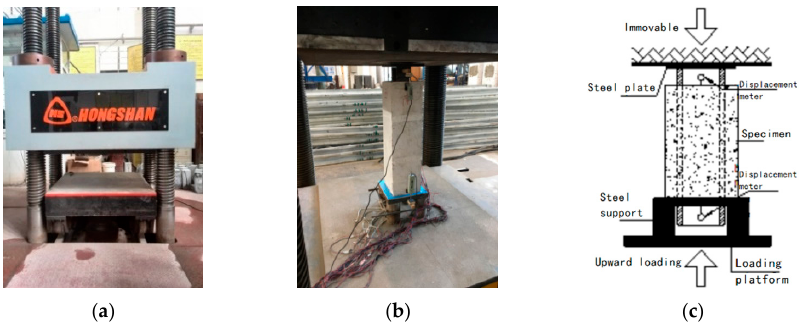
Figure 3. Photos and sketch of the test: ( a ) photo of test setup; ( b ) photo of push-out specimen; ( c ) sketch of push-out specimen.